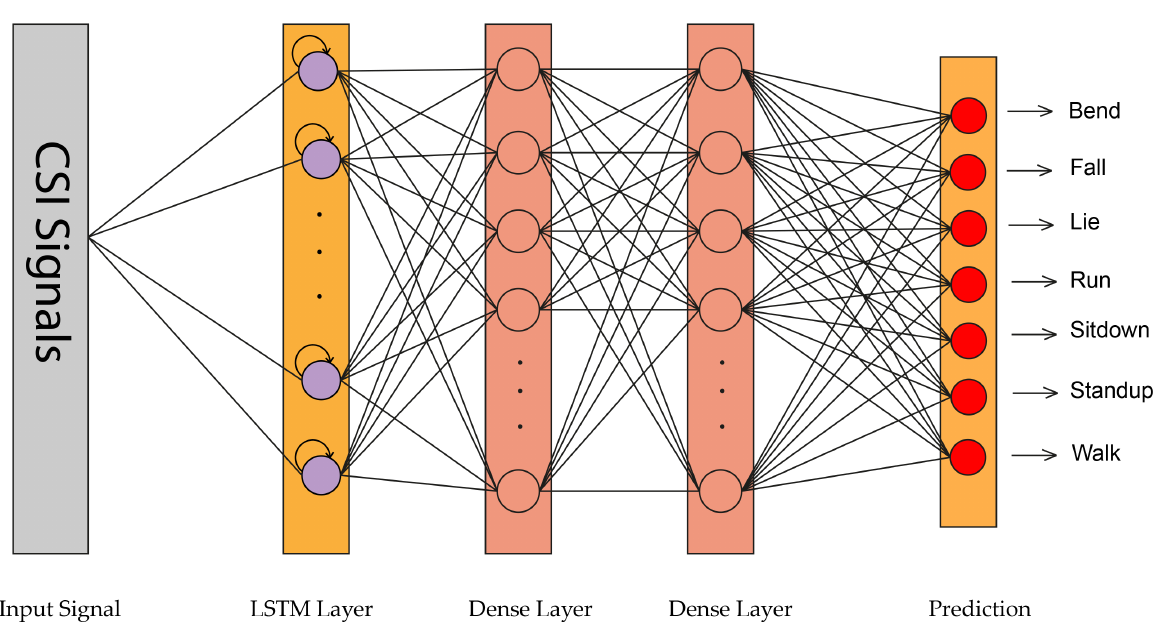
Figure 3. LSTM structure used in this